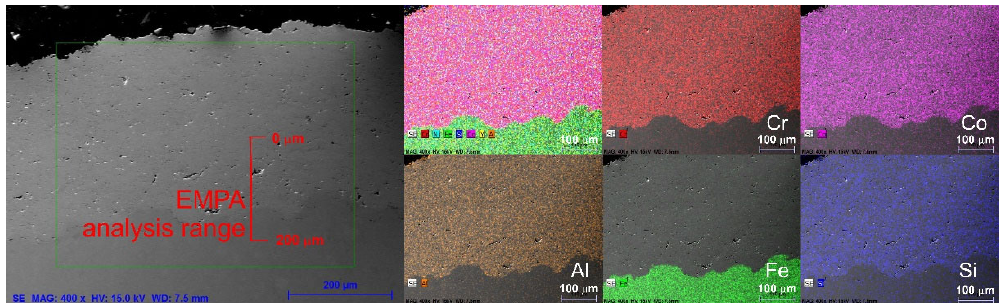
Figure 9. SEM/EDX image of the HVOF coating after 5000 h at 600 °C.